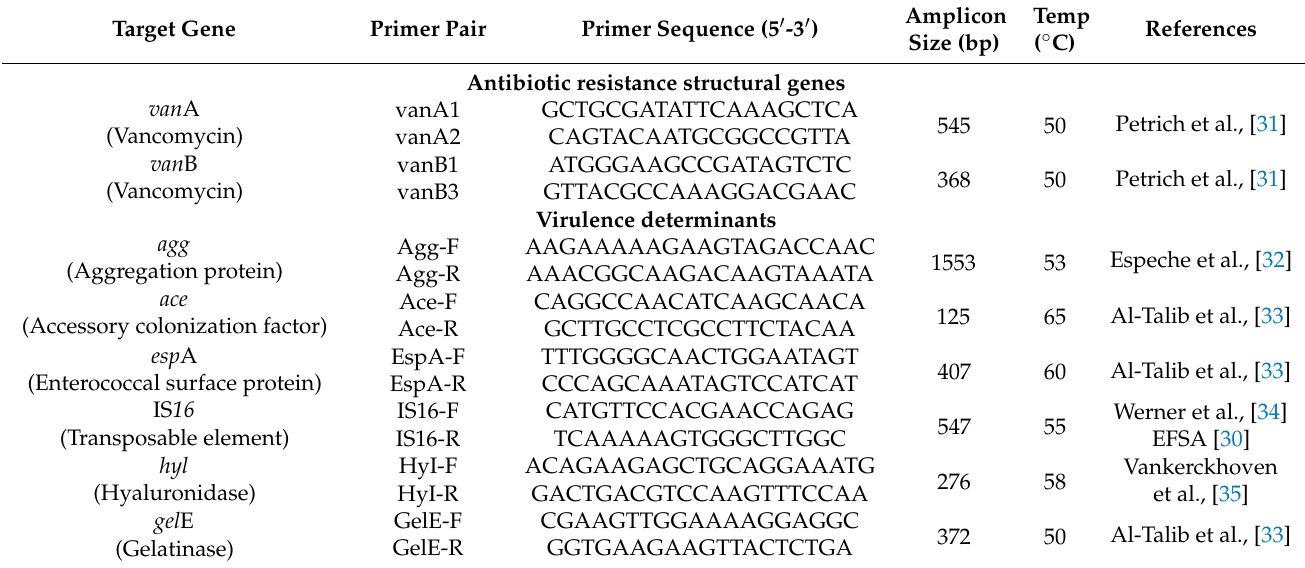
Table 2. List of primers used in the present